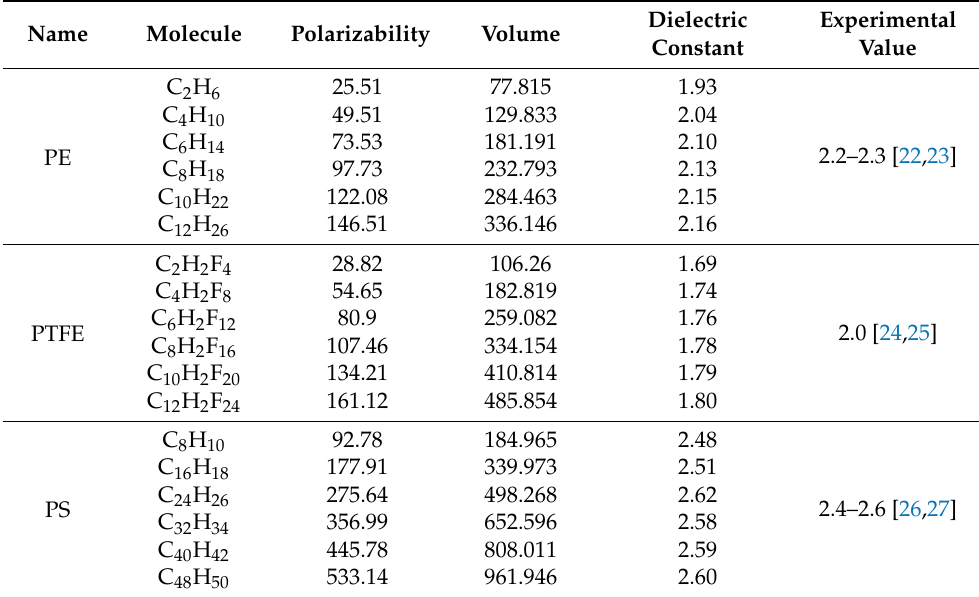
Table 2. The simulated dielectric constant for molecules with different chain lengths determined using the B3LYP/6-31+G(d, p) method. Here, the units of polarizability and volume are a 03 and Å 3 ,